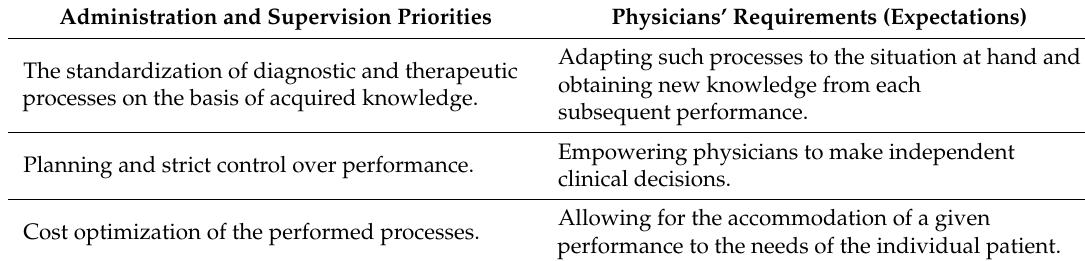
Table 1. Examples of mutually exclusive expectations for the descriptions of diagnostic– therapeutic